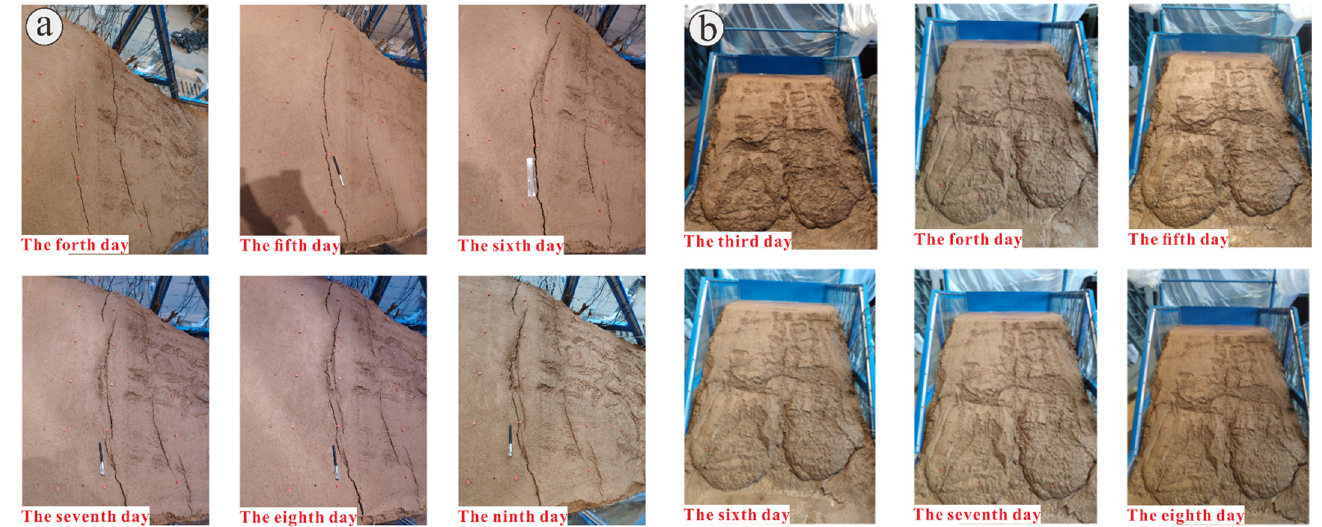
Figure 14. Deformation and failure process of fill slope under rainfall. ( a ) Crack development process near slope shoulder and ( b ) shallow sliding process.